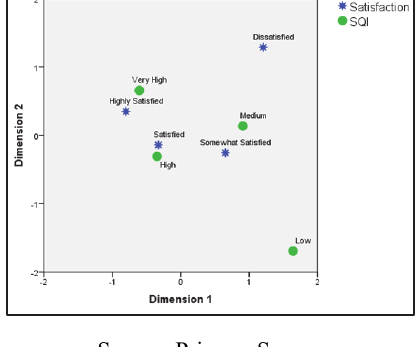
Fig. 3. Correspondence Analysis of Service Quality and Customer Satisfaction Row and Column Points-Symmetrical